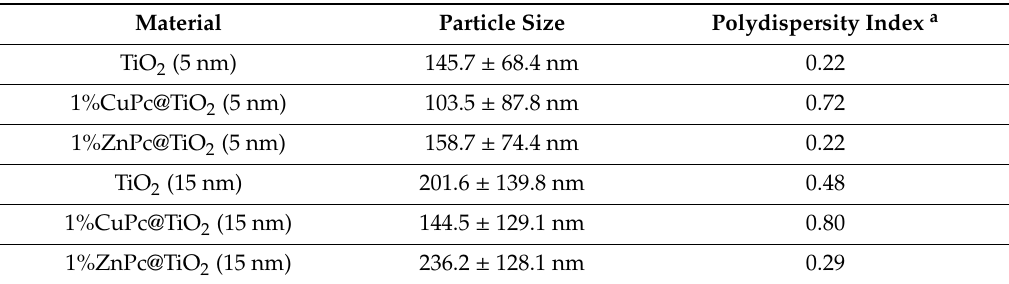
Table 2. Particle size measured for TiO 2 based materials.